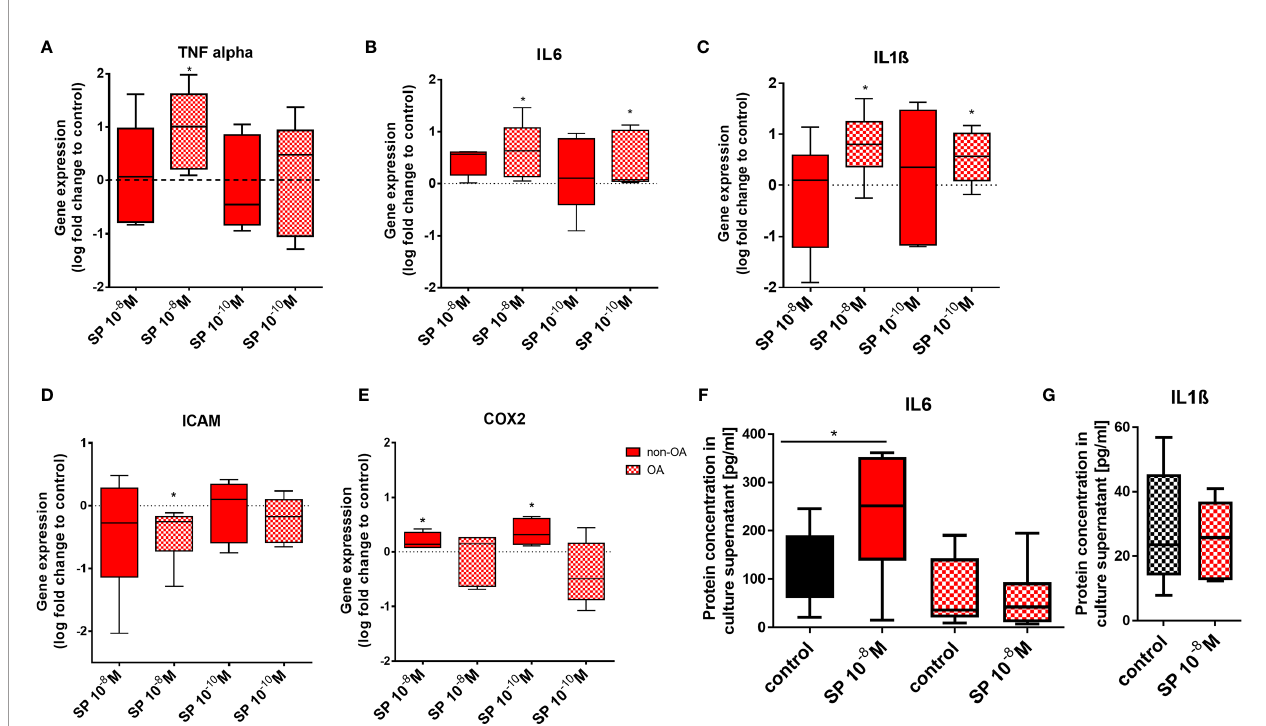
FIGURE 5 | Pro-in fl ammatory markers in 3D fi brin gels cultured OA and non-OA chondrocytes after stimulation with SP. Chondrocytes were treated with either 10 -8 or 10 -10 M SP for 7 days and then compared to the respective untreated control cells (untreated controls set to 0 or 100% = dotted line). (A – E) Quantitative RT-PCR analysis demonstrated the gene expression of TNF a , IL6, IL1ß, ICAM and COX2. (F, G) Protein concentration of IL6 and IL1ß in the culture supernatants was assayed via ELISA. Results show median (min to max); one sample t-test; *p ≤ 0,05; n =